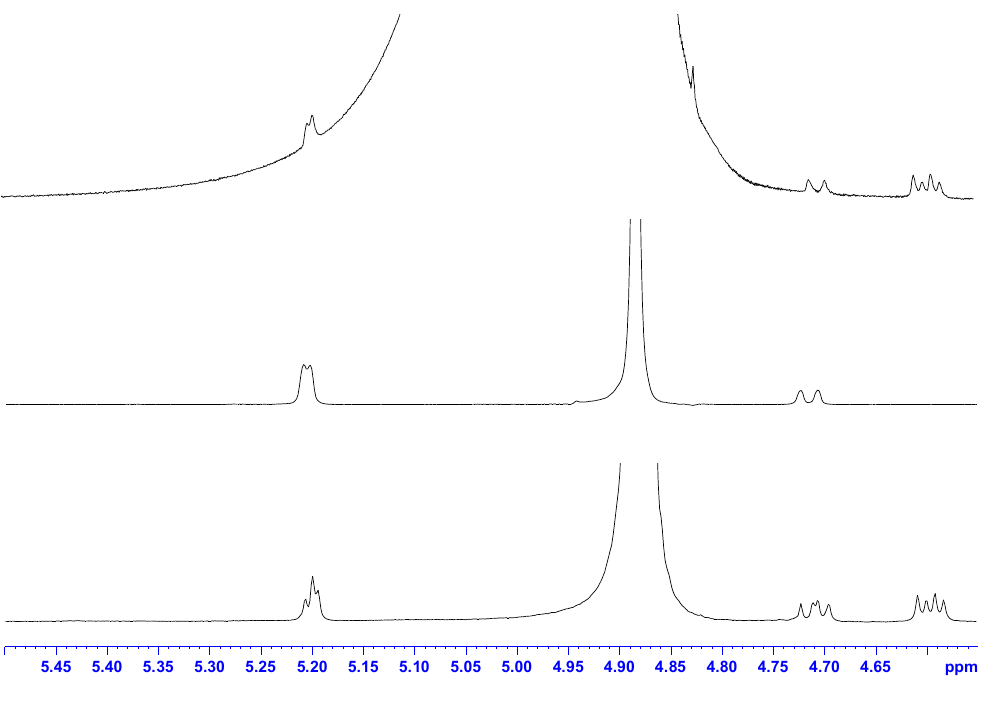
Figure 2. 1 H-NMR spectroscopy of anomeric protons of GlcNAc, (GlcNAc) hydrolyzates of chitin by chitinase at 290